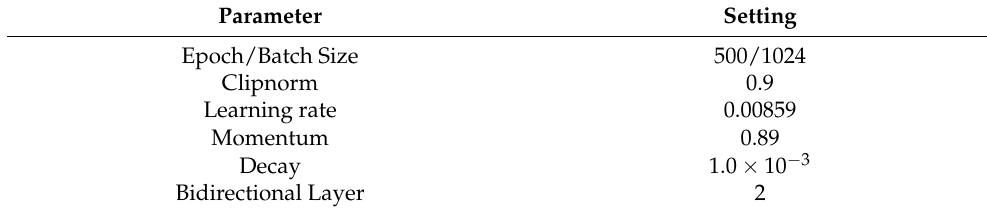
Figure 7. Configuration of the BI-LSTM. Table 3. Parameter Settings of the